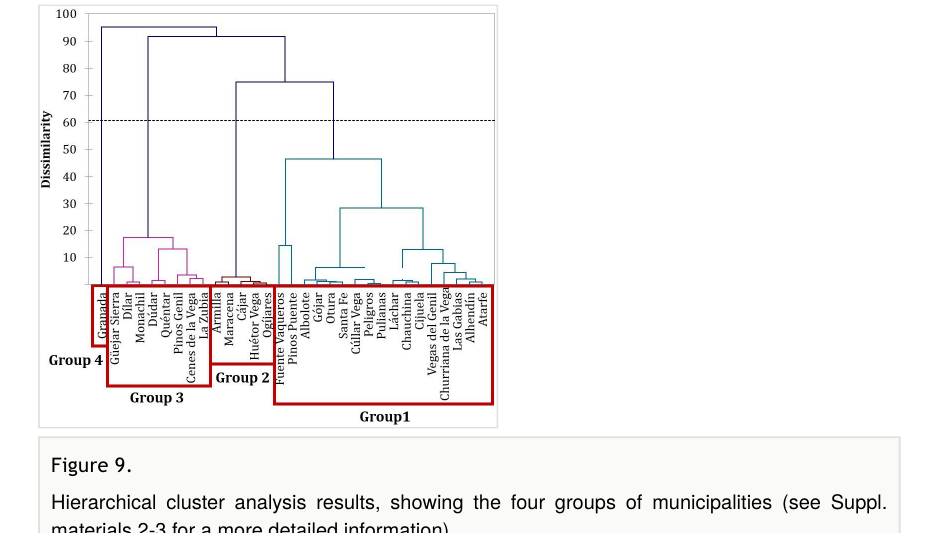
We found statistically signi fi cant di ff erences in the supply of ES amongst the four groups of municipalities (Kruskal-Wallis; =134.44; p-value<0.001). Group 1 was signi fi cantly di ff erent from groups 2, 3 and 4; while group 2 was signi fi cantly di ff erent from groups 1, 3 and 4; and groups 3 and 4 were signi fi cantly di ff erent from groups 1 and 2 (Dunn’s test, p- value<0.001). Groups 3 and 4 did not show signi fi cant di ff erences between them (Dunn’s test, p-value=0.46) (Fig. 10). The highest mean supply value corresponded to municipalities clustered in group 1 ( =4.71), followed by groups 3 ( =3.60), 4 ( =3.50) and 2 ( =1.87).